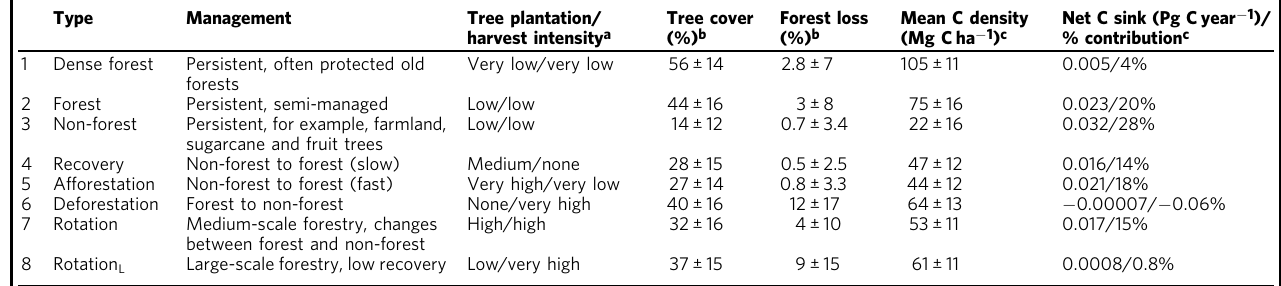
Table 1 Types of land use and land use change in southern China.